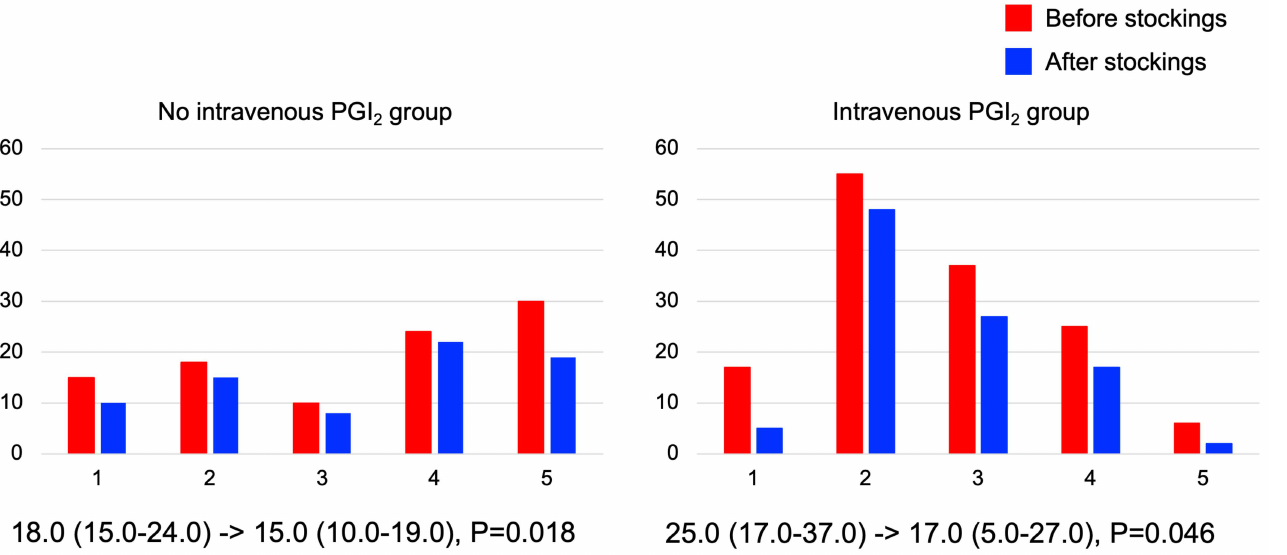
Figure 2. Effects of compression stockings evaluated by Pain Disability Assessment Scale (PDAS). Wearing compression stockings significantly improved PDAS score in both